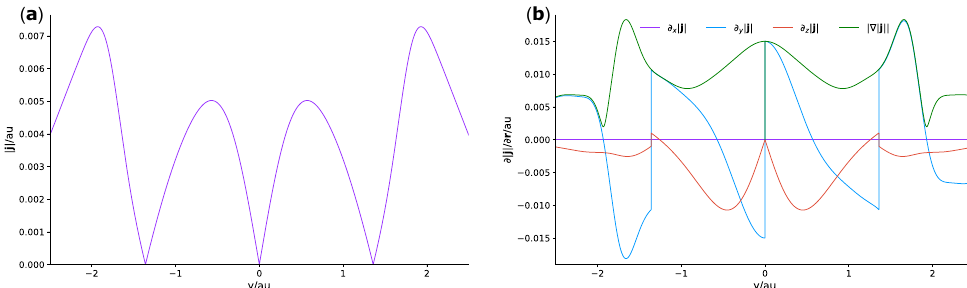
Figure 1. ( a ) The value of | j | ; ( b ) The Cartesian gradient components ∂ γ | j | and its magnitude plotted ( b ) from y = − 2.5 to 2.5 bohr at z = 2.3 bohr in the ethene molecule in the yz -plane with a magnetic field of 0.1 B 0 along the z